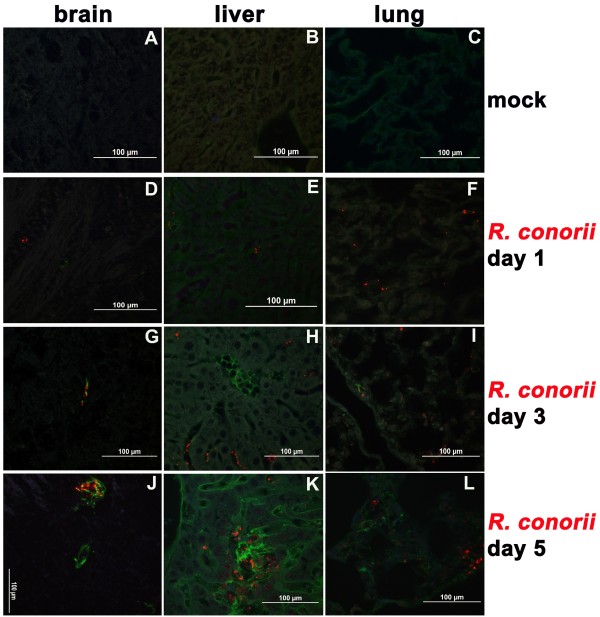
Immunohistofluorescence studies show up-regulation of ANG in microvascular endothelial layers, co-localized with SFG rickettsiae in lesions, in mouse brains, livers, and lungs on days 3 and 5 post-infection. Dual immunofluorescence staining of SFG rickettsiae (red) and ANG (green) in mouse tissues using a dual wave length filter system revealed that the ANG signal was restricted to microvascular endothelial layers in multiple organs or hepatocytes (green signals in images A-F). First appearing day 3 post-infection, compared to mock controls, R. conorii infection (2 × 105 PFU, red signal) resulted in increased signal of ANG (green signals in image G-L) in the microvascular endothelial layers in brain, liver and lung. Up-regulated ANG is co-localized with R. conorii (red signal) in lesions on day 5 post-infection (image J-L). Nuclei of mouse cells are counter-stained with DAPI (blue).